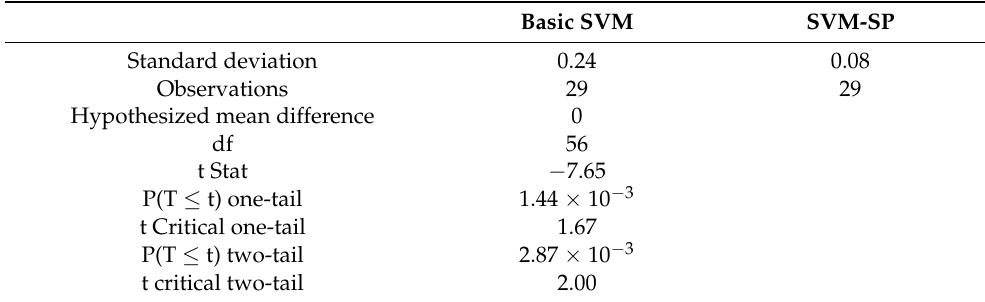
Table A7. t -Test: two-sample assuming unequal variances between basic SVM and SVM-SP, RC beam.